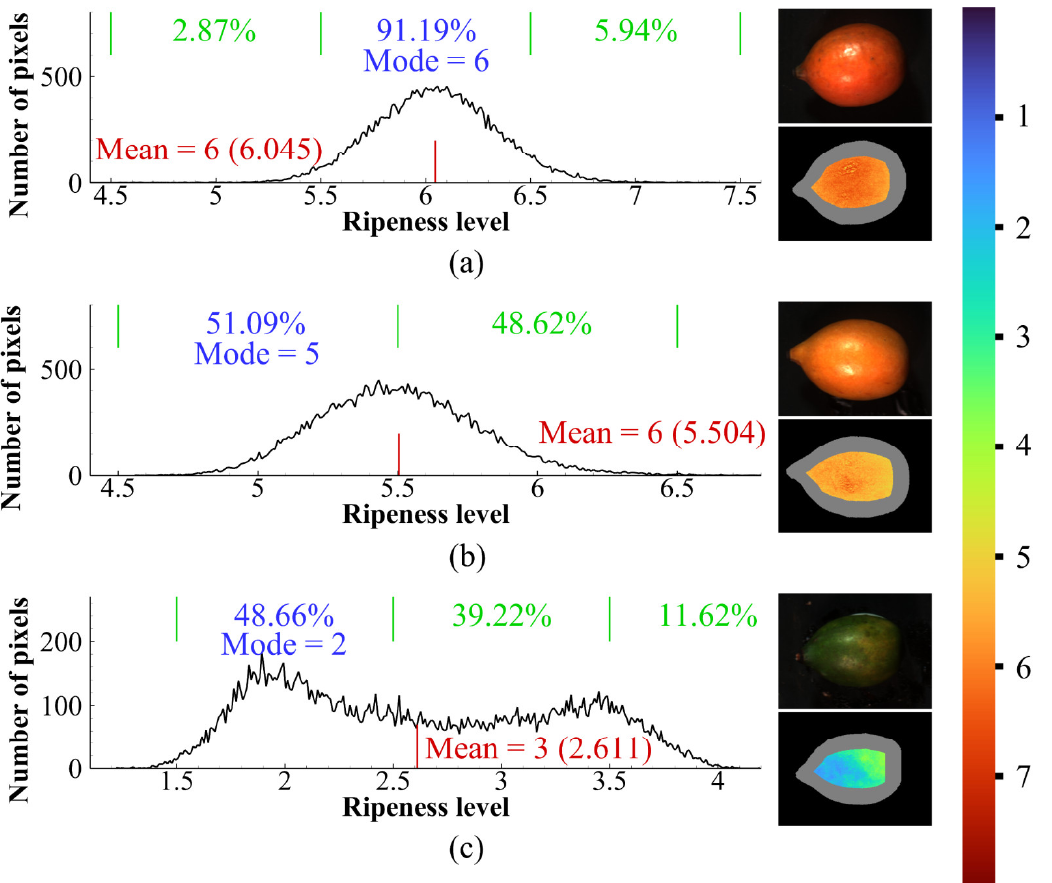
Figure 9. Ripeness evaluation of fruit samples based on classification results using different statistical methods. The histograms of pixel-based ripeness prediction results which are ( a , b ) close to Gaussian distribution and ( c ) non-Gaussian distribution.